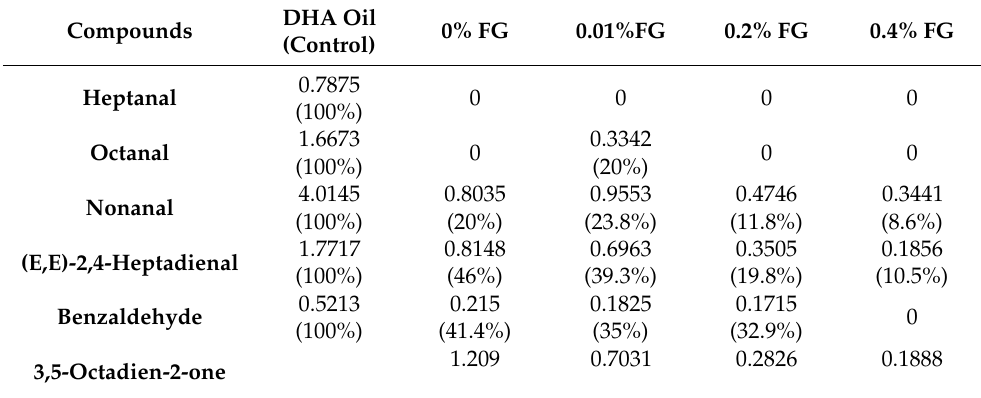
Table 1. SPME-GC-MS detects characteristic volatile compounds in different emulsion